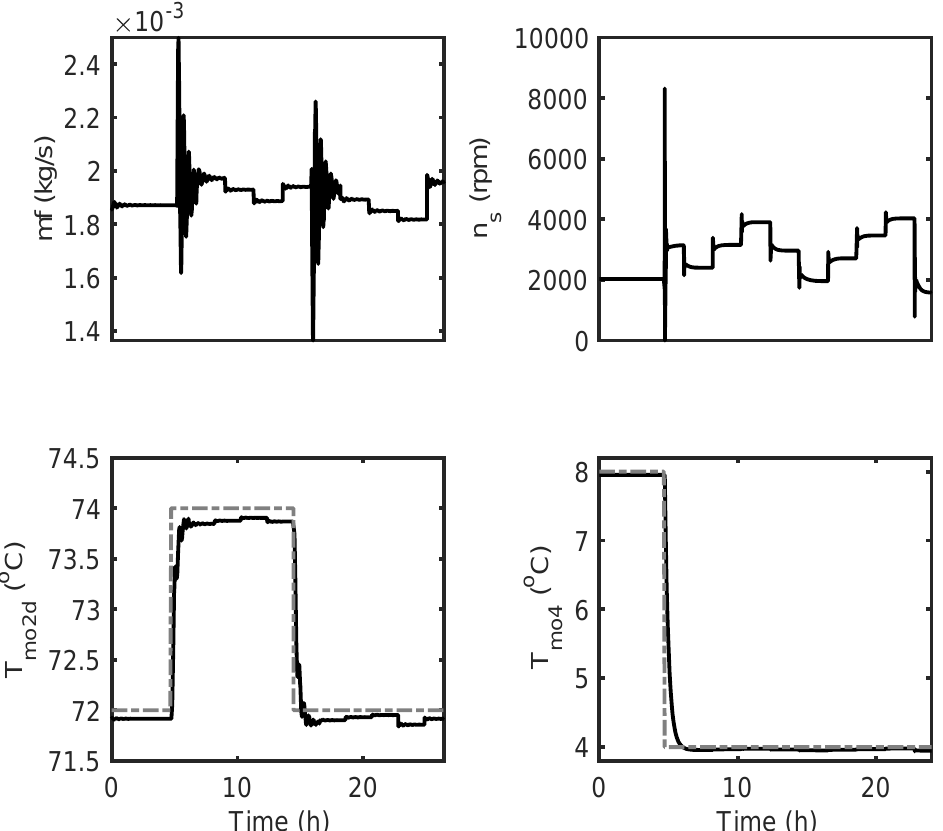
Figure 3. Controlled outputs are the temperature at the outlet of the holding tube, T mo2d ( bottom left panel ) and milk temperature at the outlet of the fourth heat exchanger, T mo4 ( bottom right panel ). Set-points for both T mo2d and T mo4 are reported with a grey dash-dotted line; manipulated inputs are fuel flow rate at boiler, m f ( top left panel ), and rotating speed at the refrigeration rate, n s ( top right panel ).